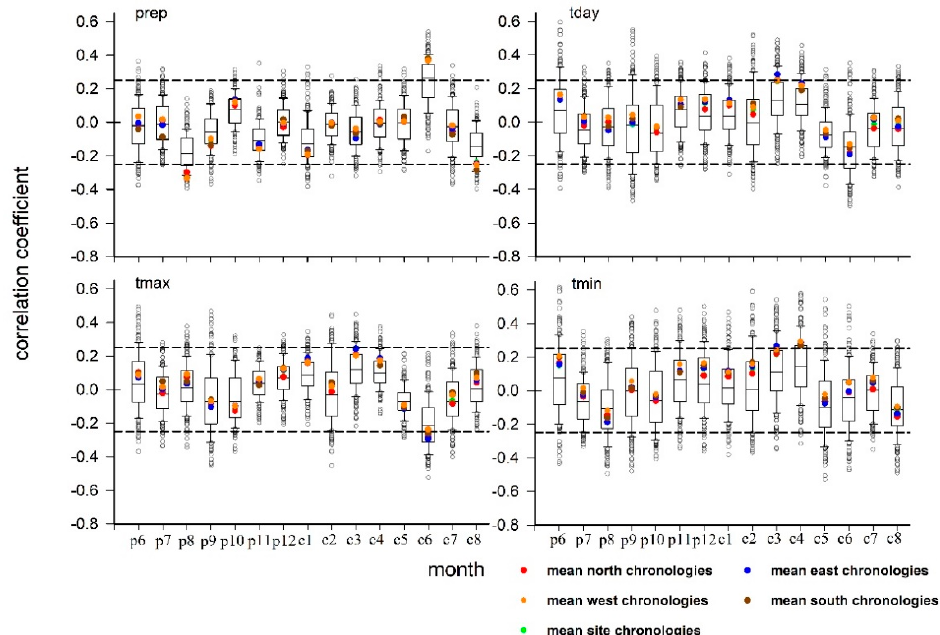
Figure 4. Correlation analysis between climatic factors and mean standard chronologies of site, north, east, west, and south. Prep is precipitation, tday is the average daily temperature, tmax is the maximum daily temperature, and tmin is the minimum daily temperature. A ‘p’ before the number of the month ( x - axis labels) represents previous year observations of each climate variable. A ‘c’ before the number of the month represents current year observations.